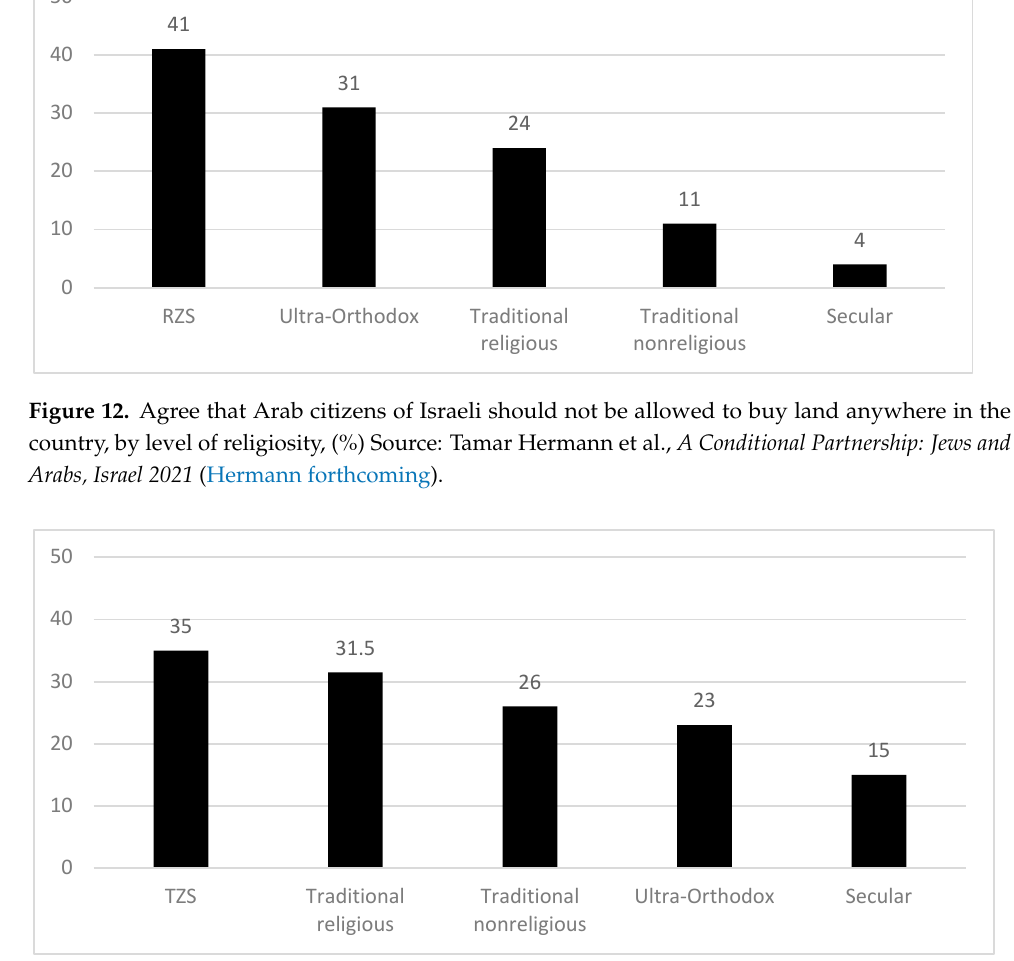
Figure 13. Agree that minority rights are overly implemented in Israel, by level of religiosity (%) (Source: Israeli Democracy Index, 2021).